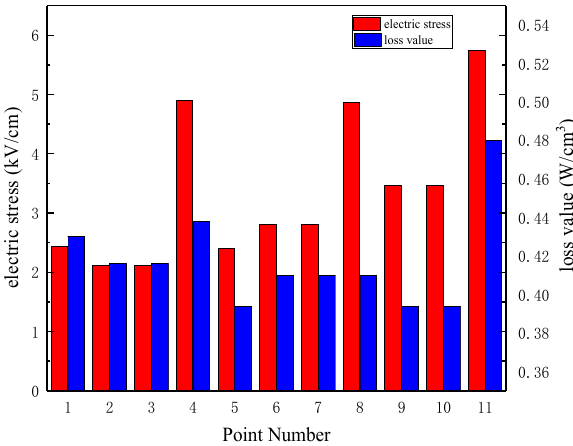
Figure 14. Maximum electric stress and loss for various resistivities of the corona protection layer.